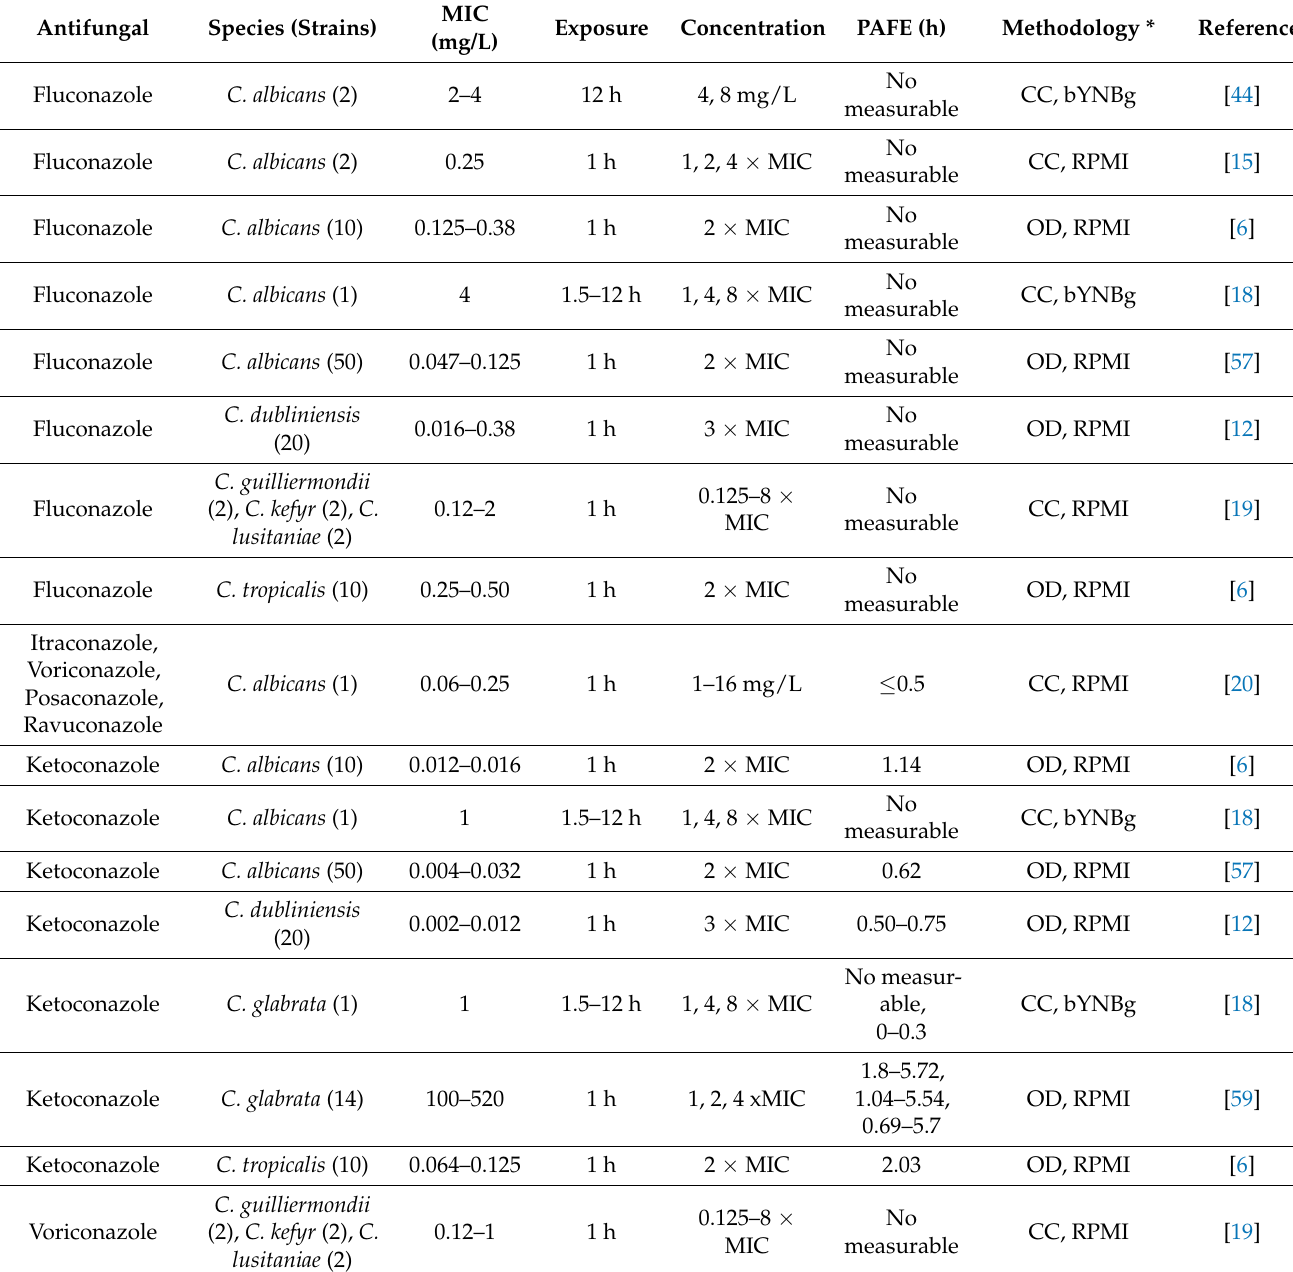
Table 2. PAFE in vitro of